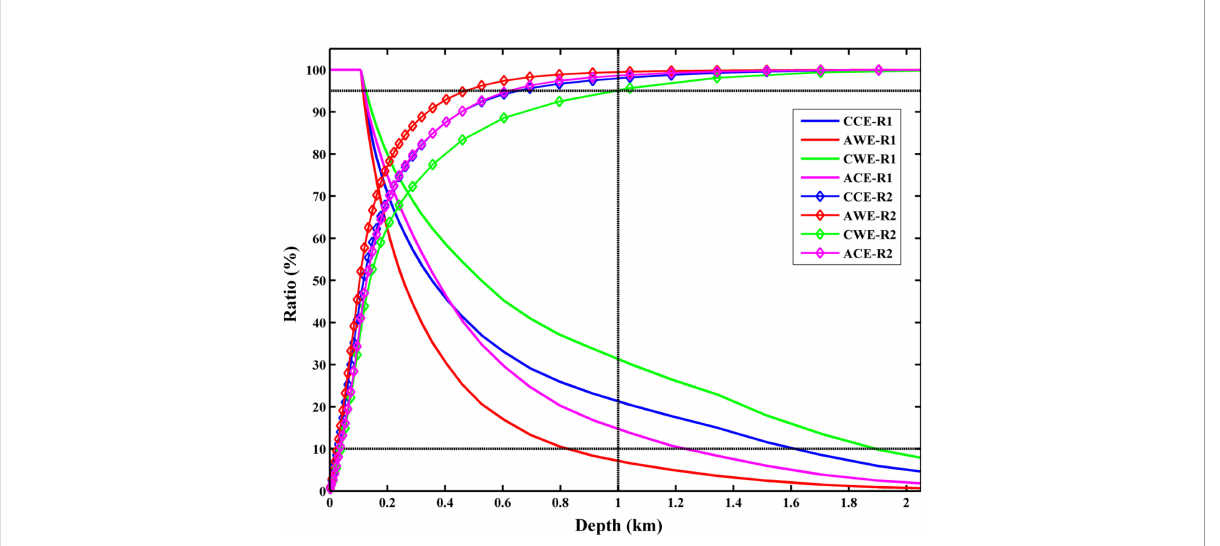
FIGURE 6 Ratio R 1 distribution of the number of four types of eddies at different depths to the total number of surface layer eddies (solid lines), and ratio R 2 distribution of the cumulative heat content in the vertical direction to the total heat content (diamond lines). The vertical black dotted line represents 1,000 m, and the horizontal black dotted lines represent 10% and 95% isobaths,